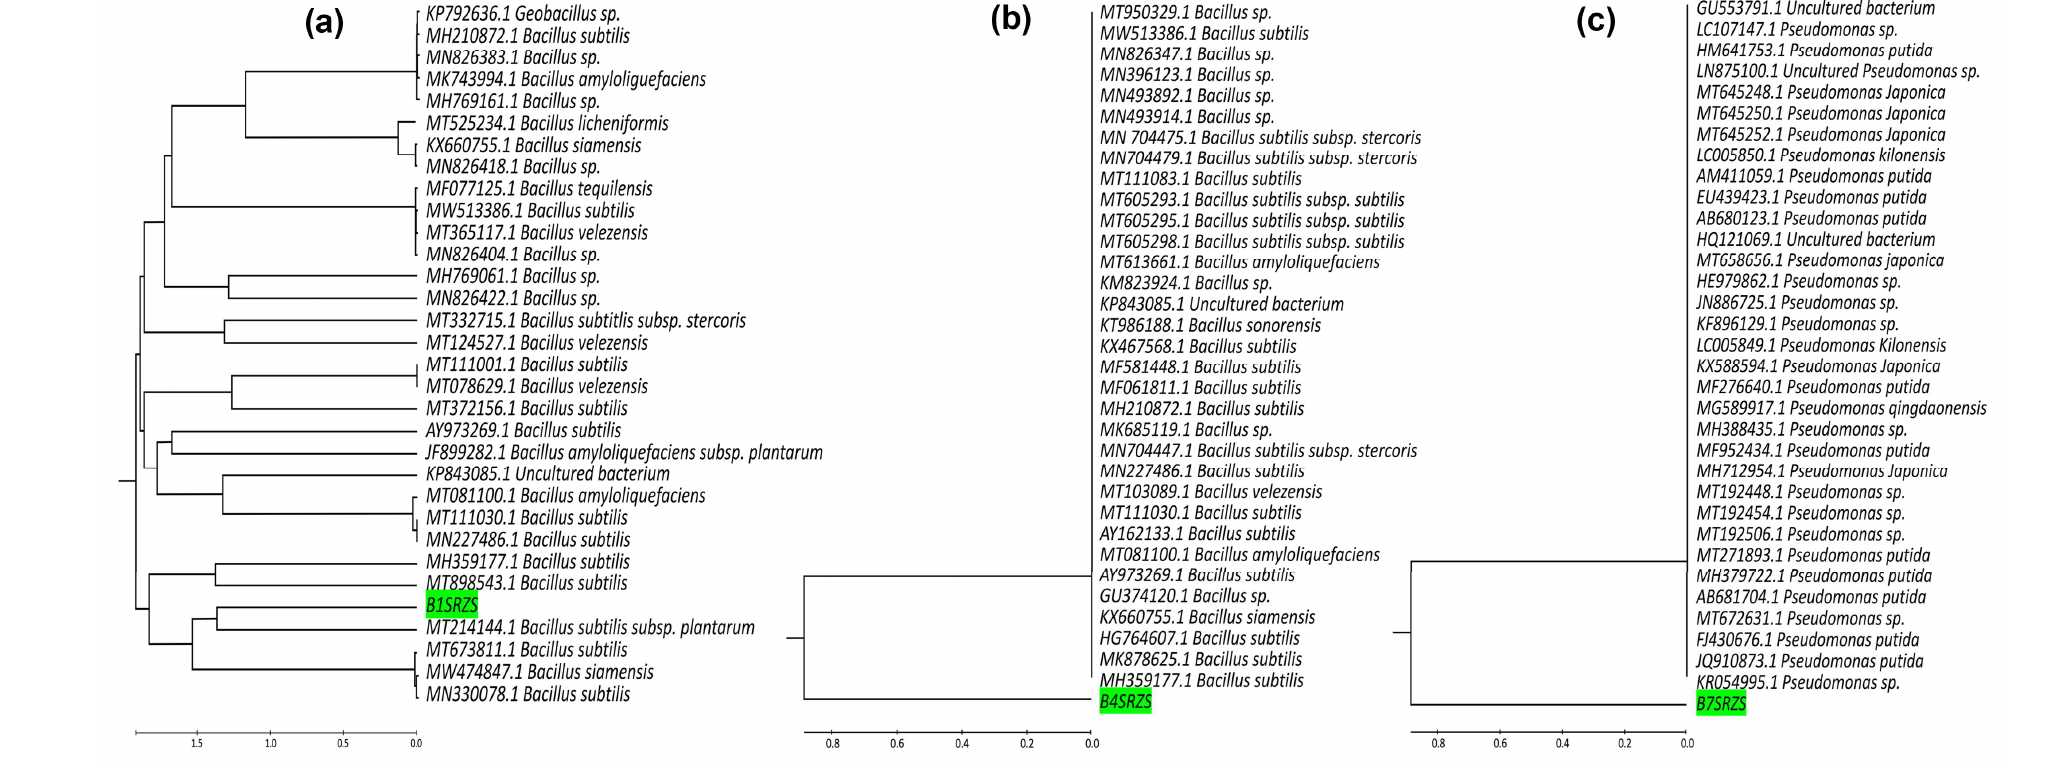
Figure 2. Phylogenetic tree of isolate coded B1SRZS, B4SRZS, and B7SRZS (( a – c ), respectively) achieved, displaying the location amid the selected bacteria based on 16Sr RNA sequence